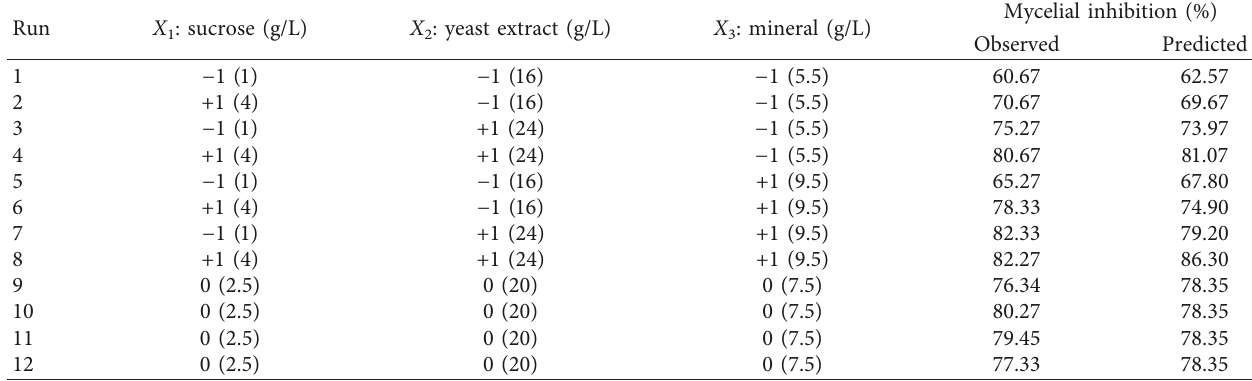
Table 1: Coded levels and real values for the experimental design and results of FFD.